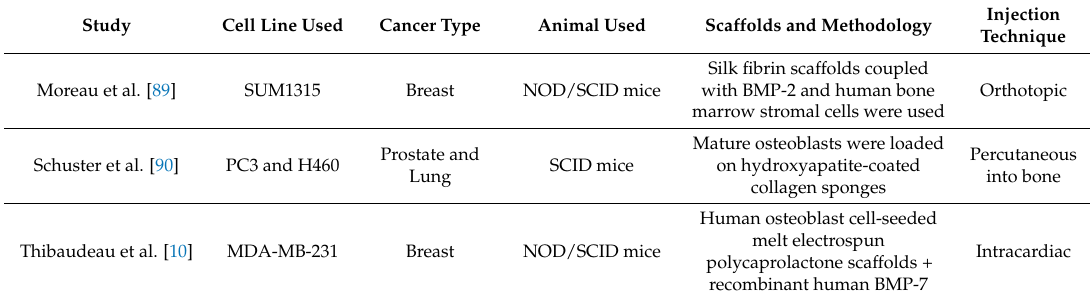
Table 5. Tissue-engineered